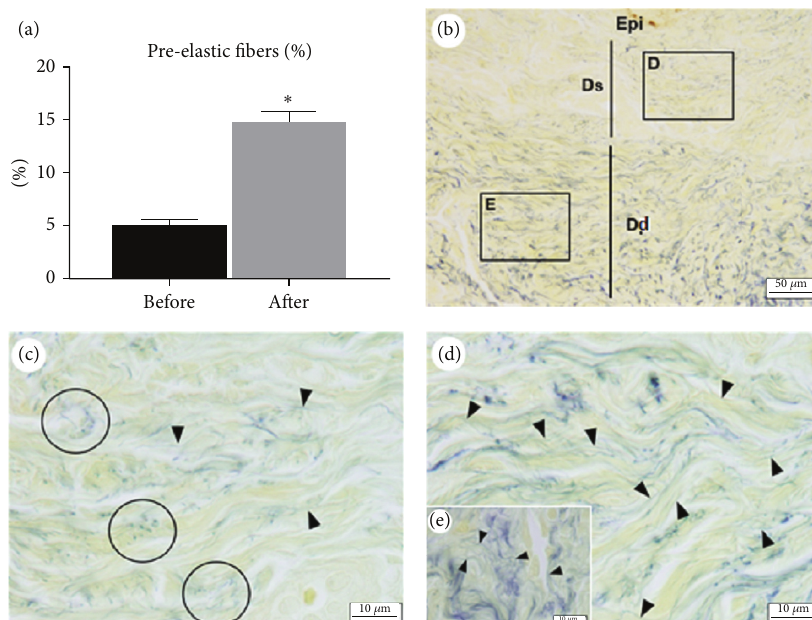
Figure 1: Preelastic fibers. (A) Graph showing a significant difference in percentage of preelastic fibers after treatment for lymphedema. (B, D, E) Dermis after treatment—note increase in preelastic fibers in superficial dermis (shown in (D)) and increase in number and thickness of fibers in deep dermis (shown in (E)). (C) Dermis before treatment—note rare preelastic fibers and regions of breakage of elastic fibers (circles). Epi, epidermis; Ds, superficial dermis; Dd, deep dermis. Arrowhead, preelastic fibers; stain, orcein and